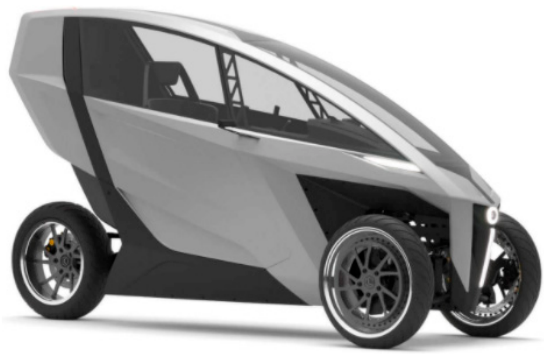
Figure 1. AKO trike P150 [37].